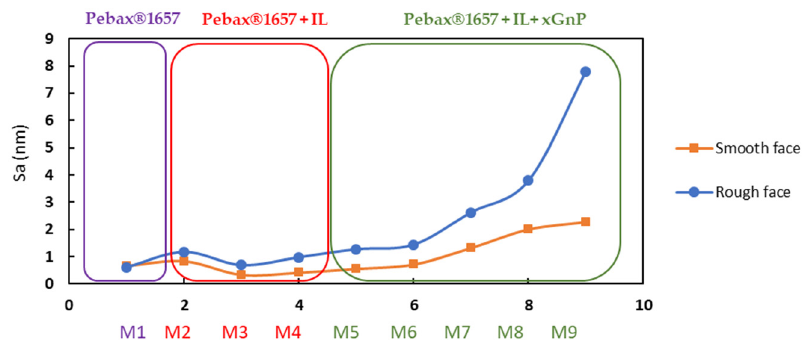
Figure 10. Trend of Sa parameter for the smooth and rough faces of Pebax (M1); Pebax/20IL (M2); Pebax/40IL (M3); Pebax/60IL (M4); Pebax/19.8IL/0.2 × GnP (M5); Pebax/18IL/2 × GnP (M6); Pebax/16IL/4 × GnP (M7); Pebax/32IL/8 × GnP (M8); and Pebax/48IL/12 × GnP (M9)—full names in Table